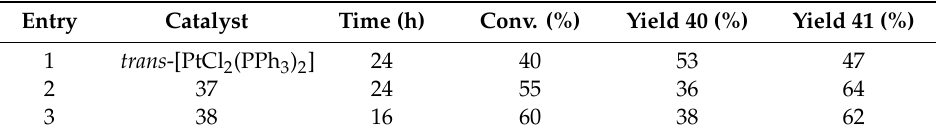
Table 8. Platinum-catalyzed hydroformylation of styrene.